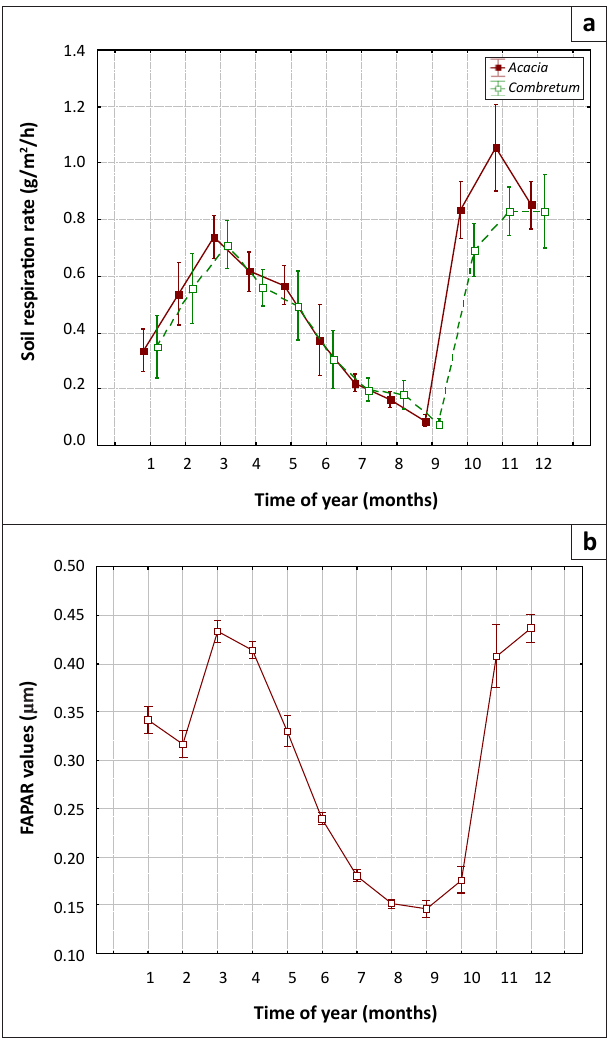
FIGURE 4: Relationship between (a) mean monthly soil respiration rate in the Acacia and Combretum savannas and (b) fraction of absorbed photosynthetically active radiation (FAPAR) values over 12 consecutitve months. Months are numbered according to the calendar